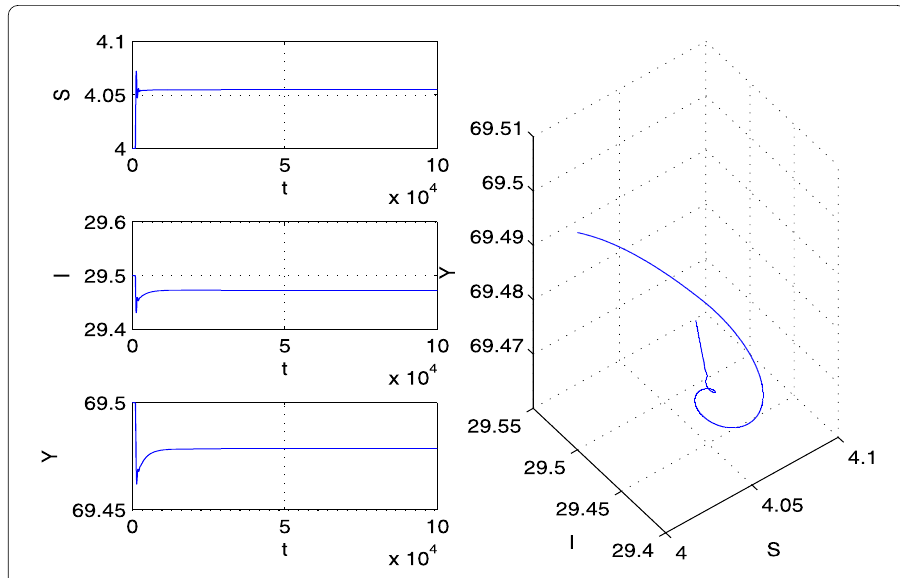
Figure 1 The trajectories of system (4.1) with τ 1 = 3 < τ 10 = 5.8744, τ 2 = 0. The positive equilibrium E is asymptotically stable. The initial value is (4,29.5,69.5)